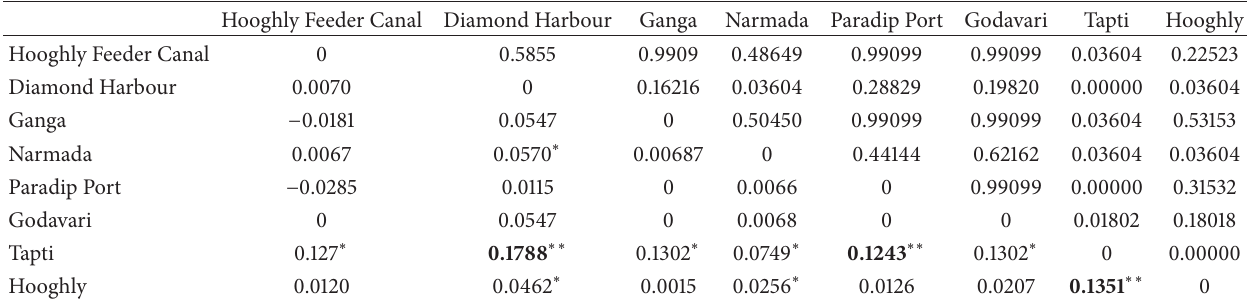
Table 4: Pairwise 𝐹 ST (below diagonal) and associated 𝑝 values (above diagonal) among T. ilisha populations. Bold values denote statistical significant values after the Bonferroni correction.